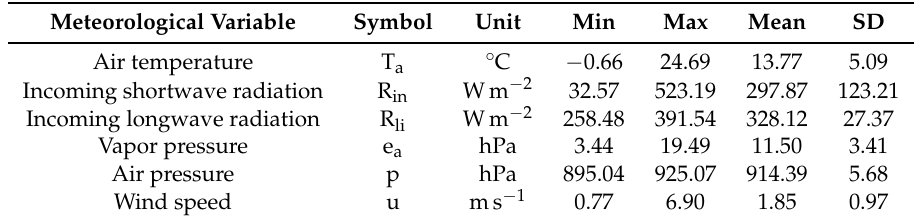
Table 1. Summary statistics of daily (means of half-hourly measurements) meteorological variables during the 2016 vegetation growing season. Min: minimum of daily means, Max: maximum of daily means, Mean: mean of daily means, SD: standard deviation of daily